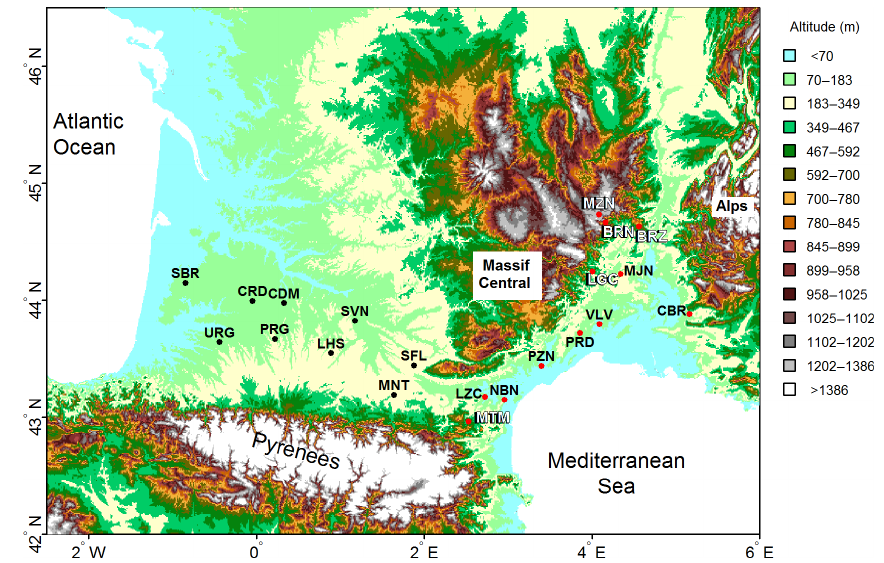
Figure 1. Locations of the 21 SMOSMANIA stations in southern France. Black dots indicate stations under oceanic and semi-oceanic climates. Red dots indicate stations under Mediterranean and Mediterranean–mountain climates. White letters are for names of the five stations under Mediterranean–mountain climates. Background geographic altitudes are from SRTM 90m digital elevation data (http://srtm. csi.cgiar.org/, last access: April